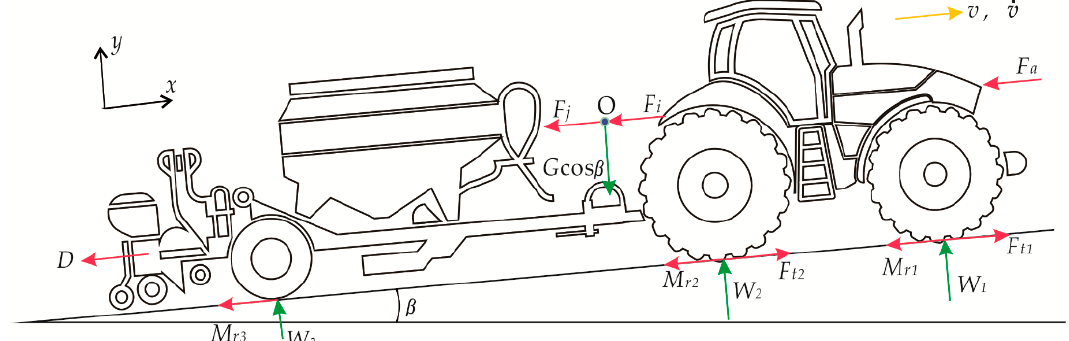
Figure 2. Schematic of external forces acting on tractor-planter combination unit.